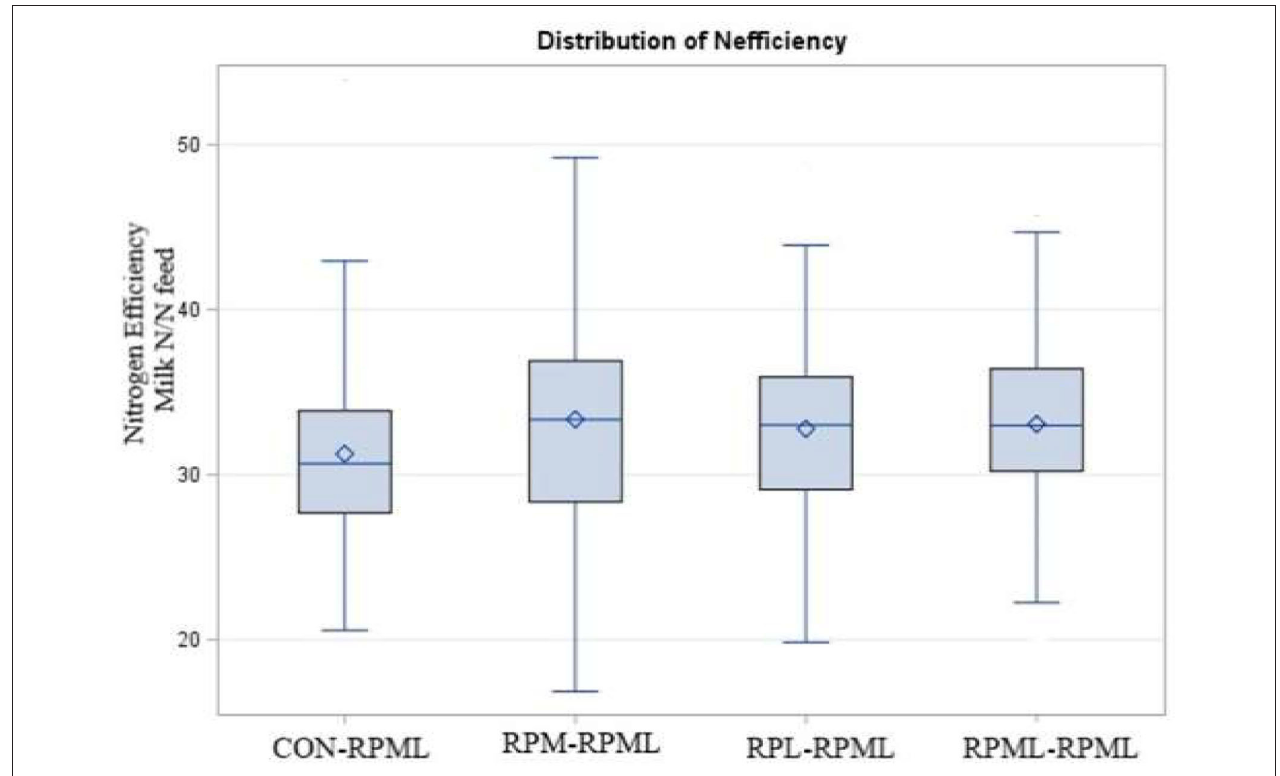
FIGURE 8 | Effect of supply ruminally protected Met and Lys to transition and milking dairy cows on nitrogen efficiency (Milk protein N/N feed intake). Values are means; standard errors are represented by vertical